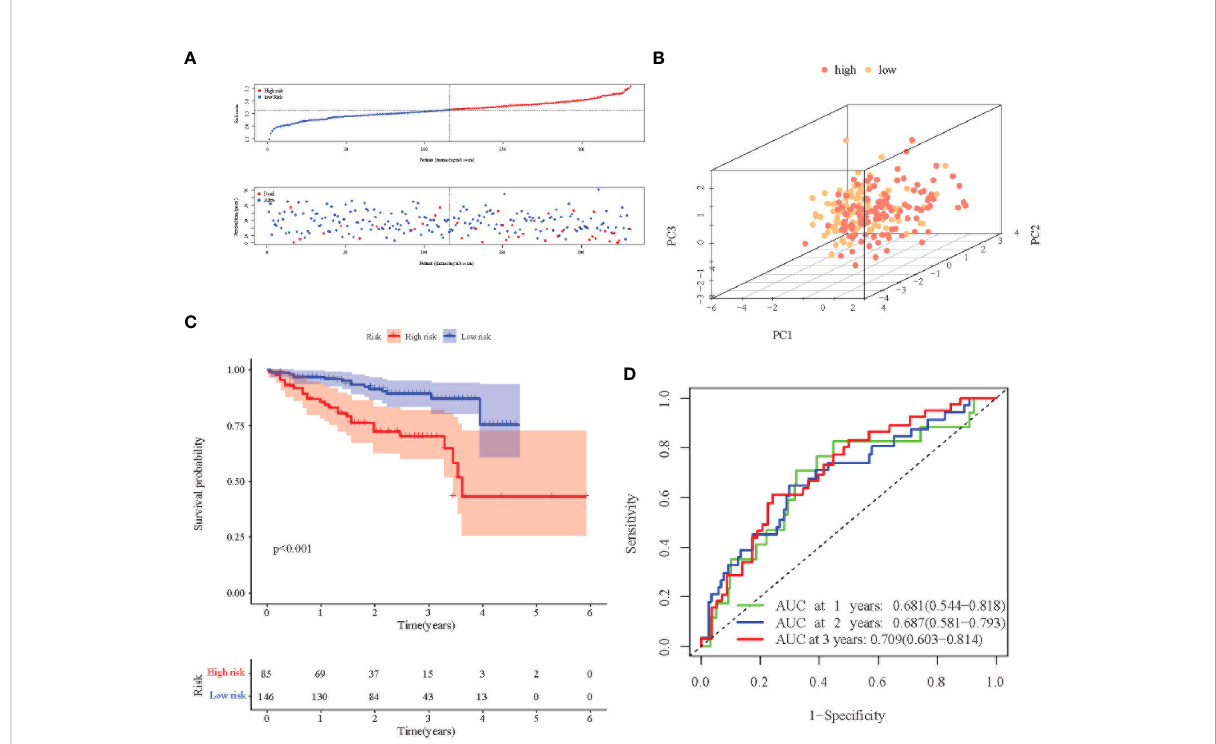
FIGURE 4 Prognostic analysis of the 8-gene signature in the ICGC cohort. (A) Distribution of risk score in high-risk and low-risk groups of the ICGC cohort; and distribution of overall survival in the ICGC cohort in different groups. (B) 3D-PCA analysis of the ICGC cohort. (C) Kaplan – Meier curve of the 8-gene signature in the ICGC cohort (P<0.05). (D) ROC analysis for risk signature at 1,2, and 3 year survival time in the ICGC cohort.